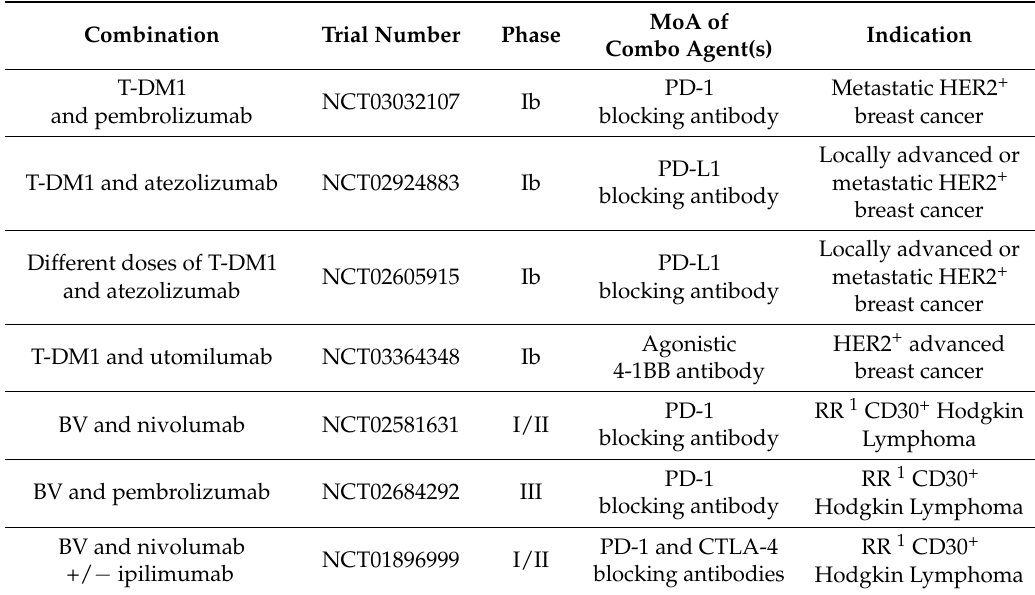
Table 3. Selected ongoing clinical trials which have combined antibody-drug conjugates (ADCs) with immune checkpoint inhibitor